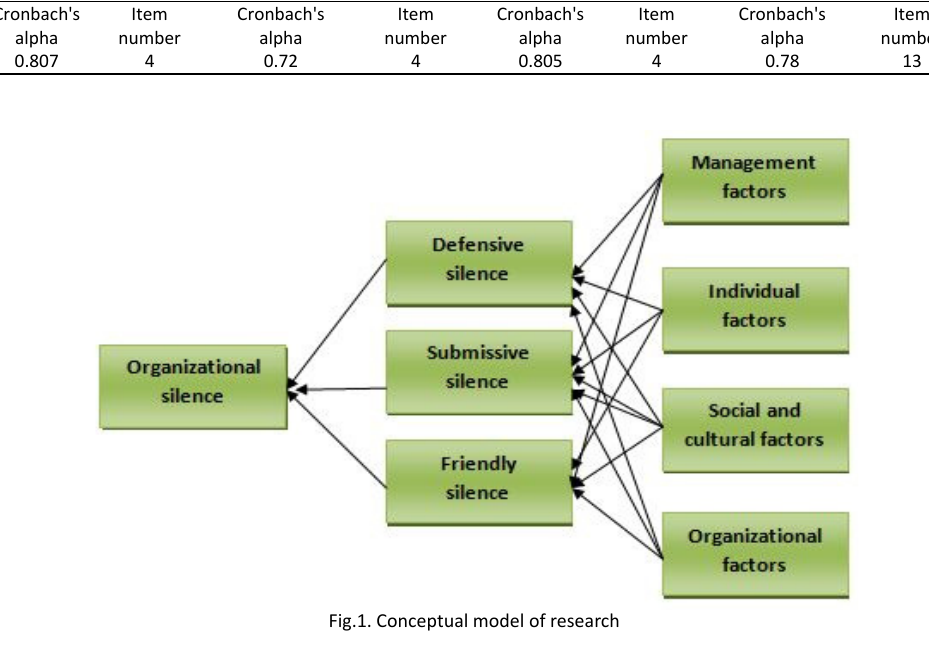
Fig.1: Conceptual model of research